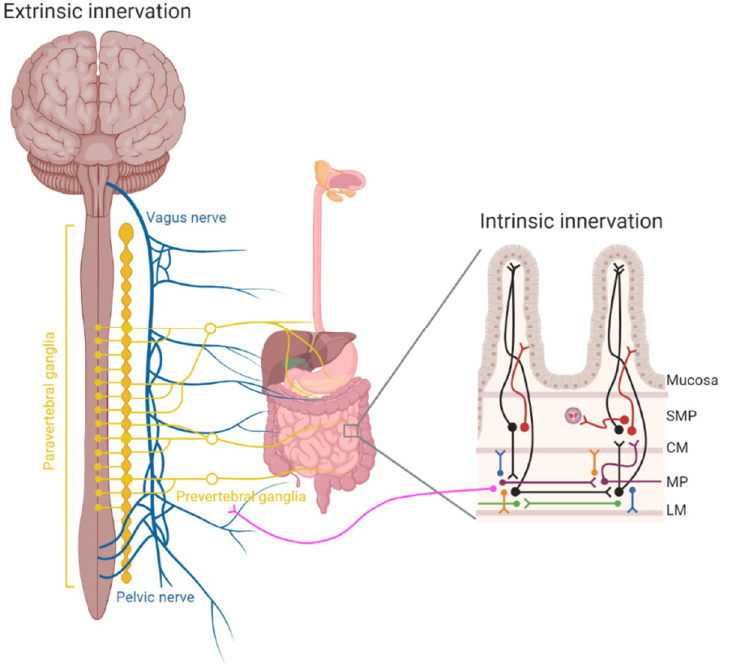
Figure 1. Schematic of the extrinsic and intrinsic innervation of the gastrointestinal tract. Extrinsic innervation comprises both the sympathetic (yellow) and the parasympathetic (blue) nervous system. The sympathetic nervous system has cell bodies located in paravertebral ganglia (next to the spinal cord) and prevertebral ganglia (close to the gastrointestinal tract). The parasympathetic nervous system projects to the stomach, small intestine, colon, and rectum via the vagus nerve and the pelvic nerve. Intrinsic gastrointestinal innervation is provided by the enteric nervous system, which comprises multiple neuronal types clustered within the myenteric plexus (MP) and submucosal plexus (SMP). The major neuronal types in the enteric nervous system are intrinsic primary afferent neurons (sensory neurons with Dogiel type II morphology that project to the mucosa, black), de- scending (purple) and ascending (green) interneurons, secretomotor and vasodilatator neurons (red), excitatory (blue) and inhibitory (orange) motorneurons, and intestinofugal neurons (pink). SMP, submucosal plexus; CM, circular muscle; MP, myenteric plexus; LM, longitudinal muscle. (Created with